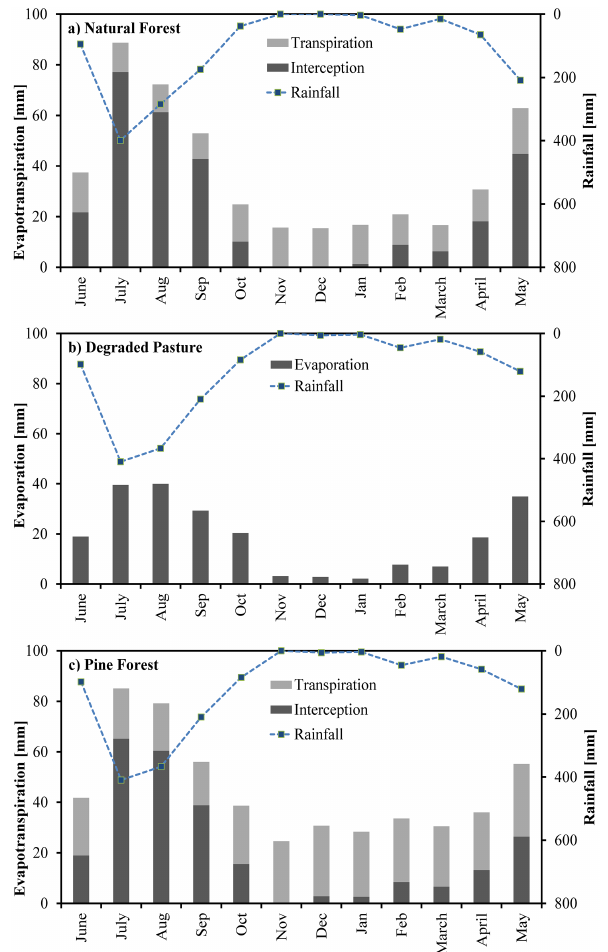
Figure 2. Monthly rainfall, interception and transpiration totals (mm) between 1 June 2010 and 31 May 2011 in (a) natural broadleaved forest, (b) degraded pasture, and (c) planted pine forest near Dhulikhel, central Nepal.